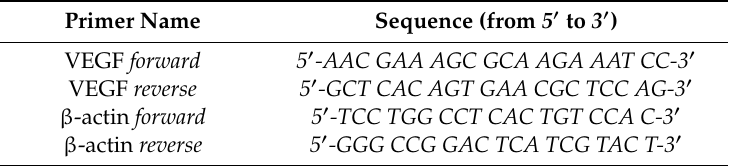
Table 1. Primers for rat β -actin and vascular endothelial growth factor